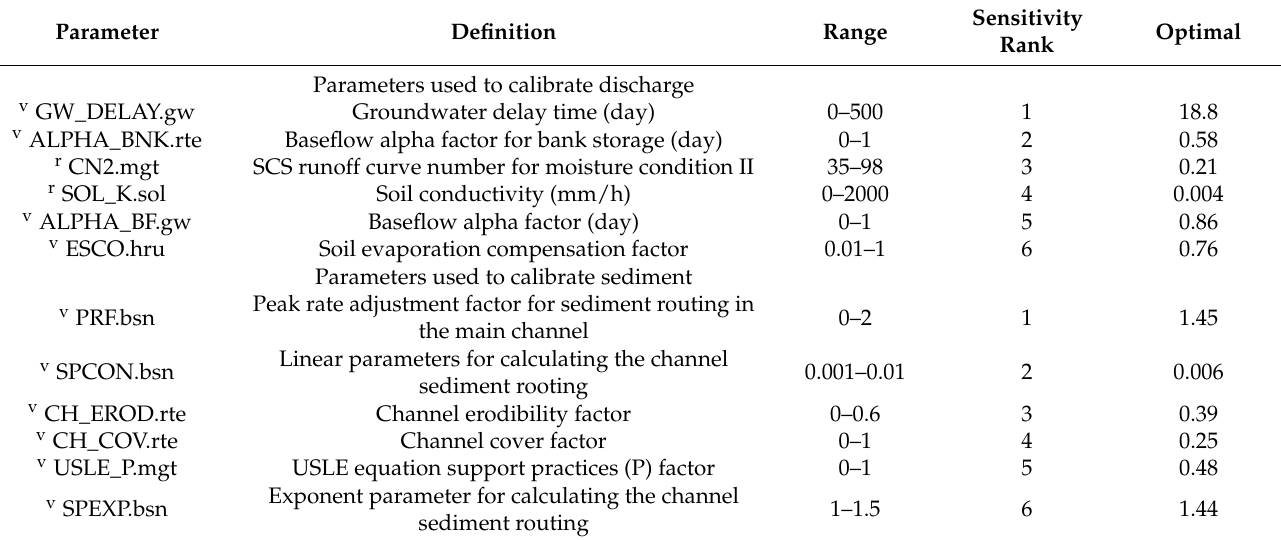
Table 2. Calibrated parameters for discharge and sediment load at the Shenyang Hydrologic Station.